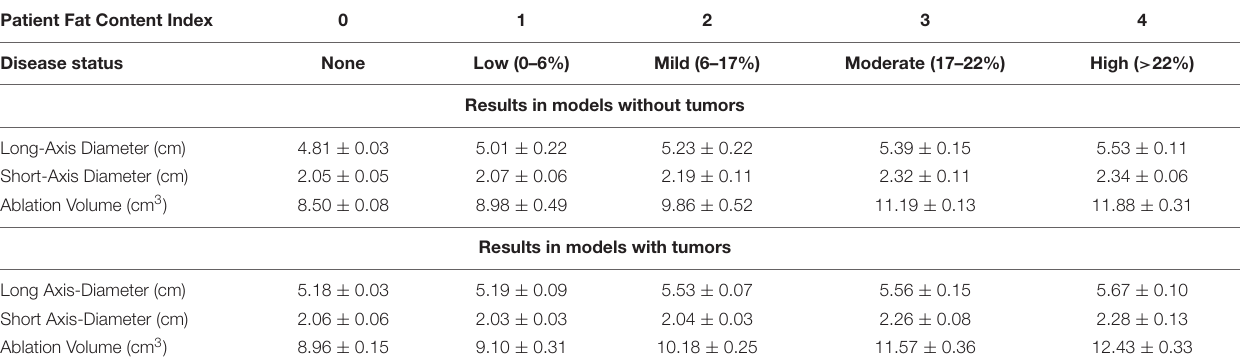
FIGURE 3 | (A–D) Fat fraction image segmented with ROIs in patient with low-fat (A) , mild-fat (B) , moderate-fat (C) , and high-fat (D) . (E) Histogram of fat-encoded intensity values segmented from mDIXON fat fraction images of 4 patients belonging to different liver-fat disease states (Low, Mild, Moderate, High). Average fat percentages are shown in legend. TABLE 3 | Disease status and fat-content range for each patient, with average ± SD of the final ablation volume (cm), long distance diameter (cm), and short distance diameter (cm) with and without a